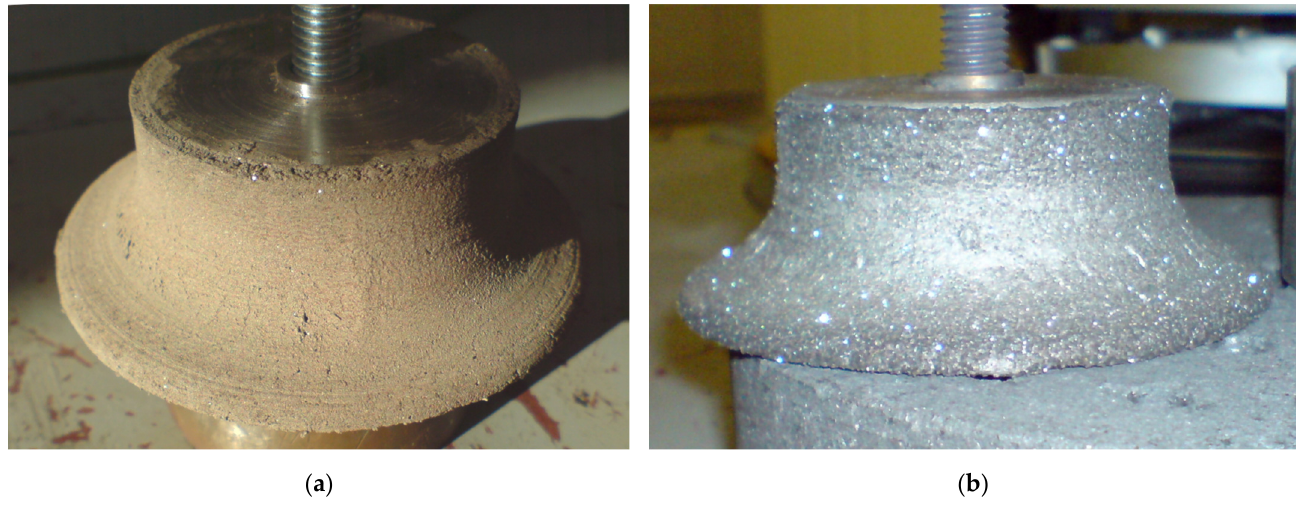
Figure 7. Specially-shaped grinding wheel with the diamond-containing mixture rolled on ( a ) and sintered ( b ).